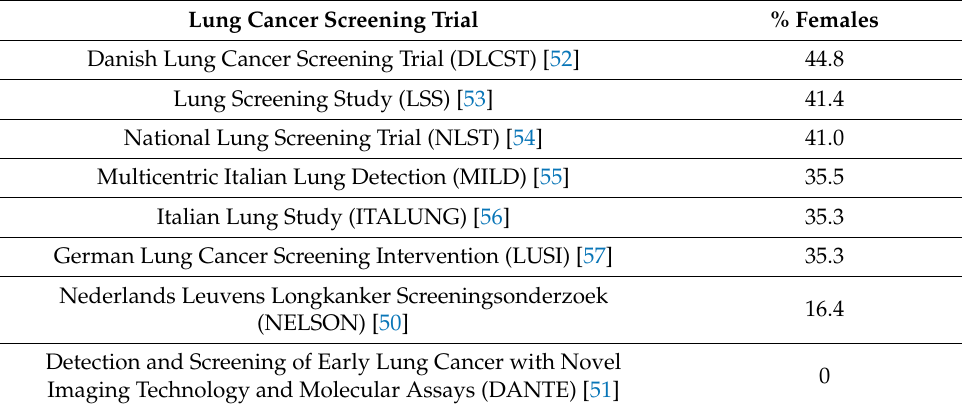
Table 3. Percentage of women in lung cancer screening